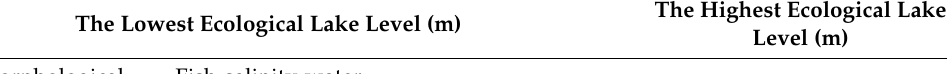
Table 5. Ecological water levels of Ulungur Lake calculated by different methods.